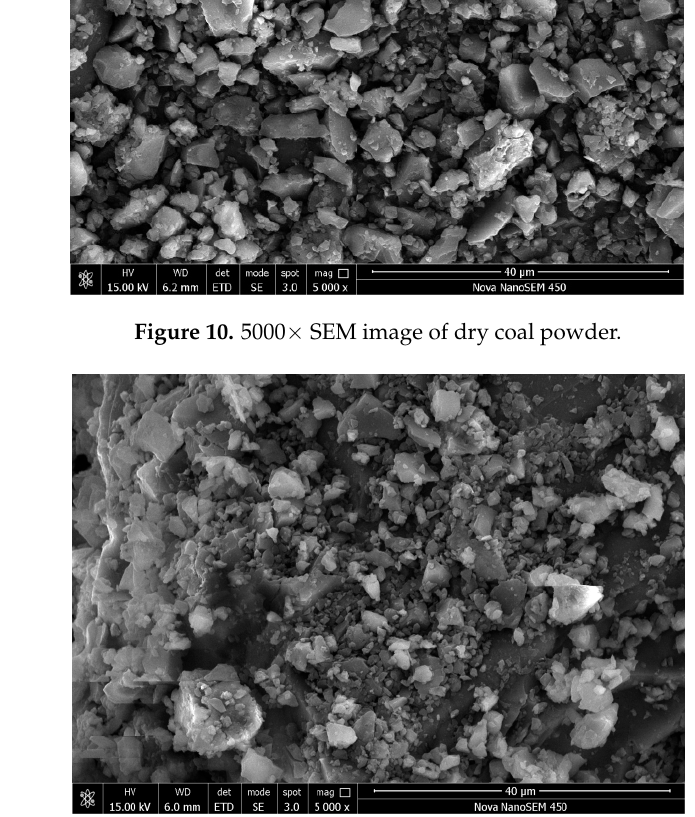
Figure 11. SEM photo of coal powder treated with SPI.